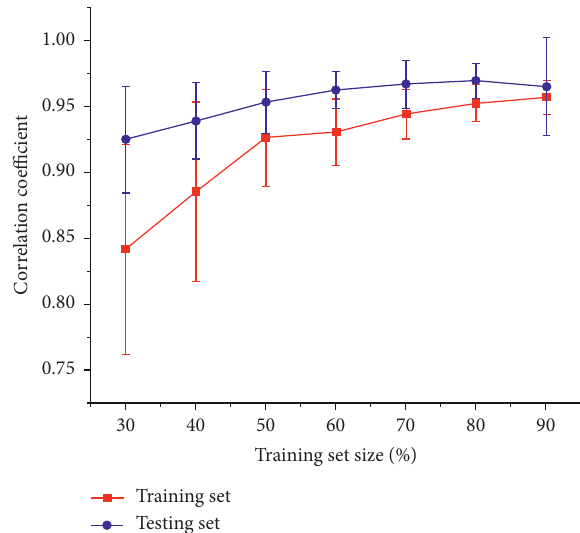
Figure 7: Influence of training set size on the performance of ANN